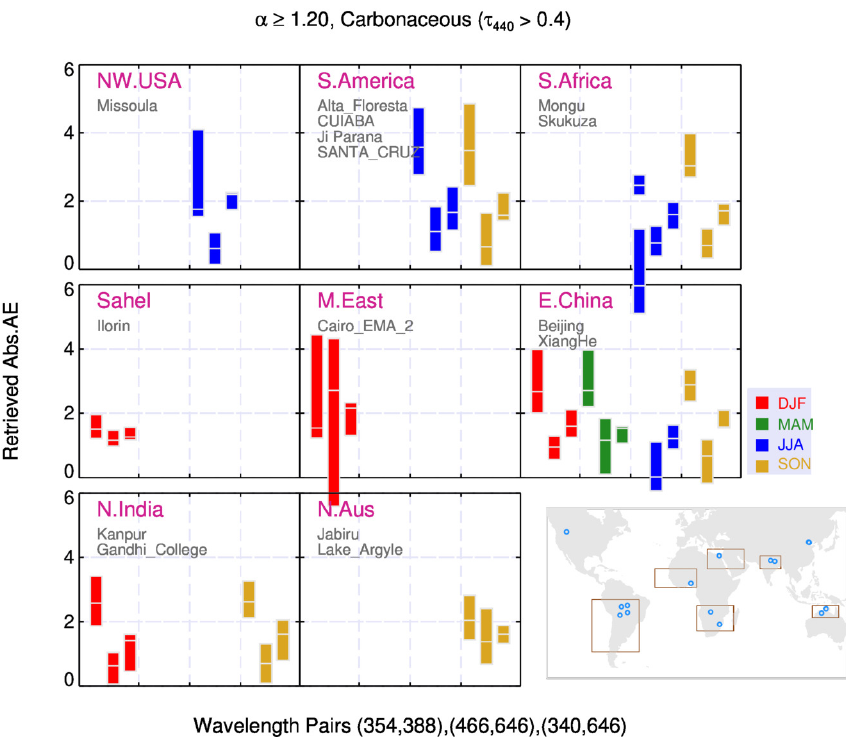
Figure 15. Absorption Ångström exponent derived at three wavelength pairs for observations with τ 440 > 0 . 4 for the fine-mode carbonaceous aerosols. The boxplot represents the lower and upper quartile of observations with the mean as the white line.